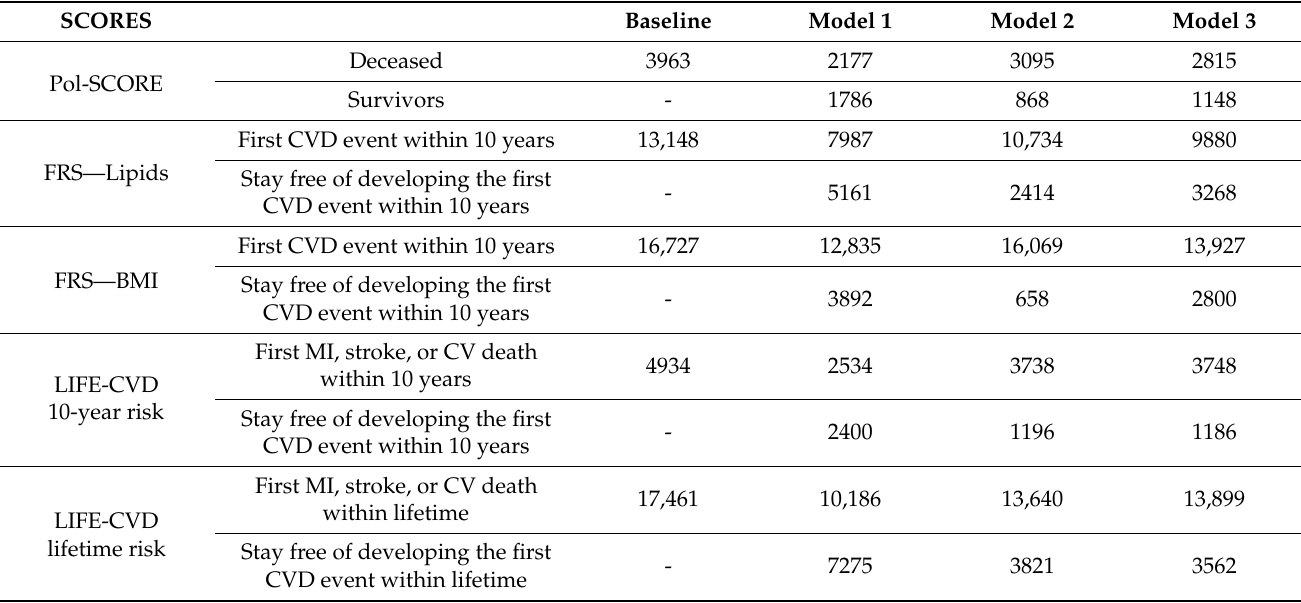
BMI model; ( C ), probability of survival-free heart attack or stroke—increase in life years (LIFE-CVD) ( D ). Variables are presented as means and 95% confidence interval (95% CI). Table 5. Estimated number of local the inhabitants who would survive (Pol-SCORE) or who would not develop a first CVD event within 10 years (Cardiovascular Disease Framingham Heart Study) or who would not develop MI, stroke, or CV death (lifetime-perspective model for individualizing cardiovascular disease prevention strategies in apparently healthy people LIFE-CVD) within 10 years or within their lifetime after applying prevention strategies.